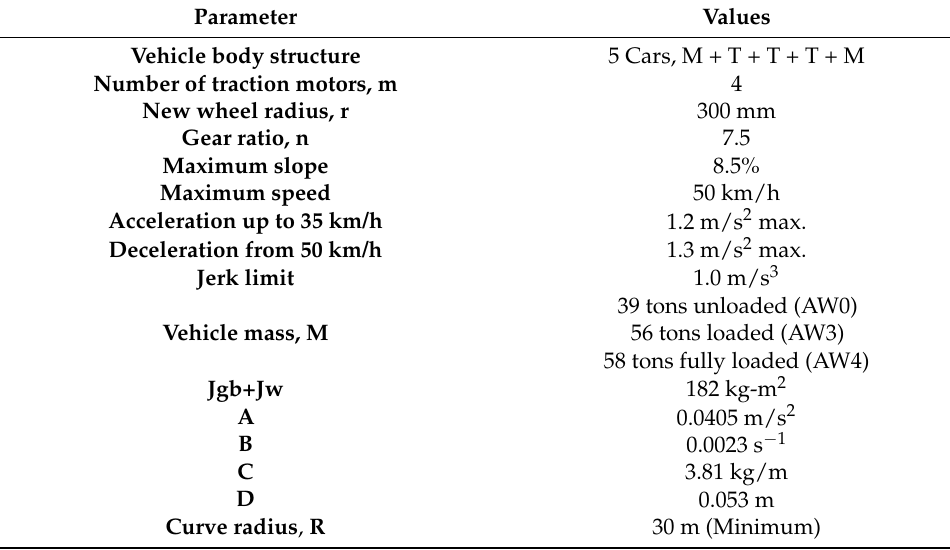
Table 1. Technical specifications of the vehicle system and its rail track.